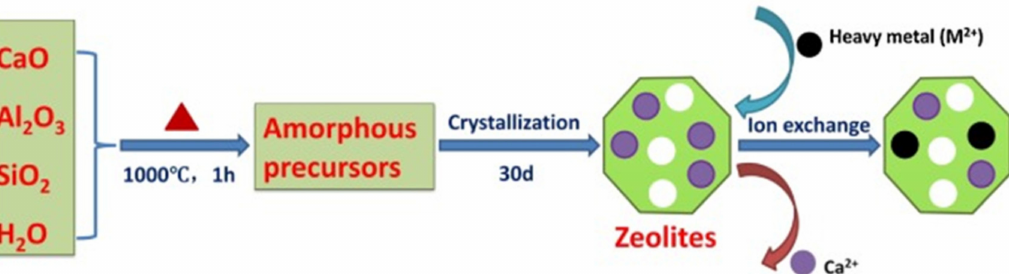
Figure 7. The mechanism of Cd (II) and Pb (II) ions adsorption in montmorillonite and zeolites by ion exchange method. Adapted with permission from Reference